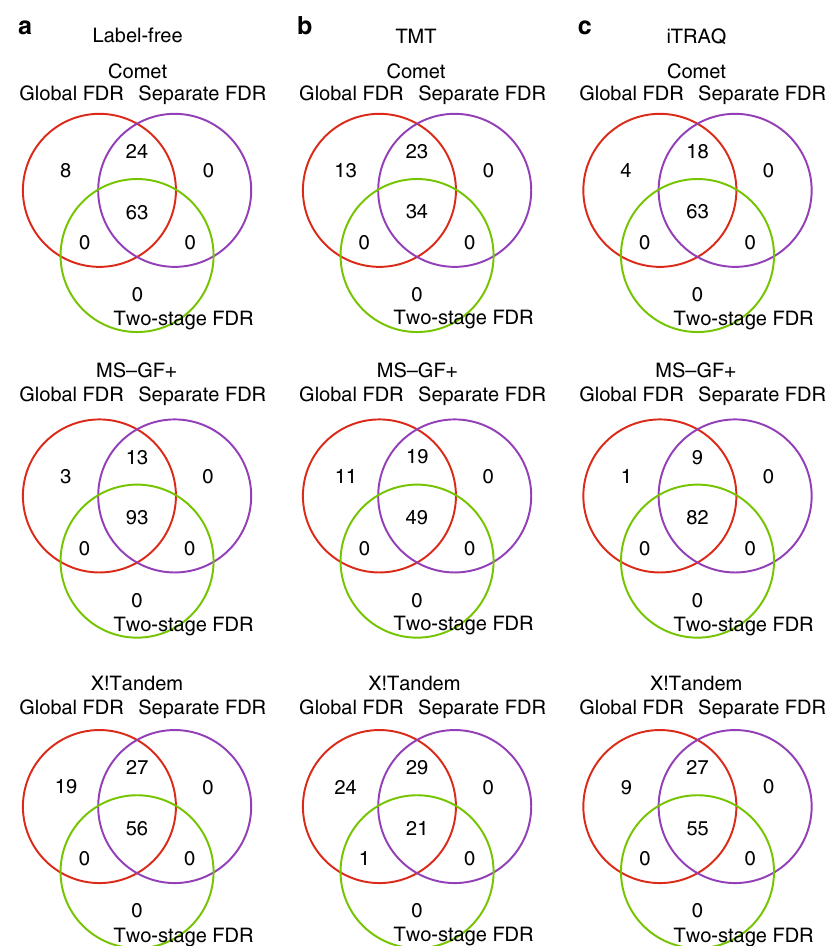
Fig. 6 Comparison of somatic mutations supported by variant peptide identi fi cations. Venn diagrams of somatic mutations supported by variant peptides identi fi ed by different methods in the label-free data a , the TMT data b , and the iTRAQ data c . Source data are provided as a Source Data fi (Fig. 6a), global FDR reported peptide evidence for 95, 109, and 102 somatic mutations using Comet, MS-GF + , and X!Tandem, respectively, and these numbers were 70, 79, and 75 for the TMT data set (Fig. 6b), and 85, 92, and 91 for the iTRAQ data set (Fig. 6c). On average, separate FDR and two-stage FDR only provided evidence for 88% and 63% of somatic mutations that were supported by global FDR. For neoantigen prediction, we further predicted MHC-I bind-